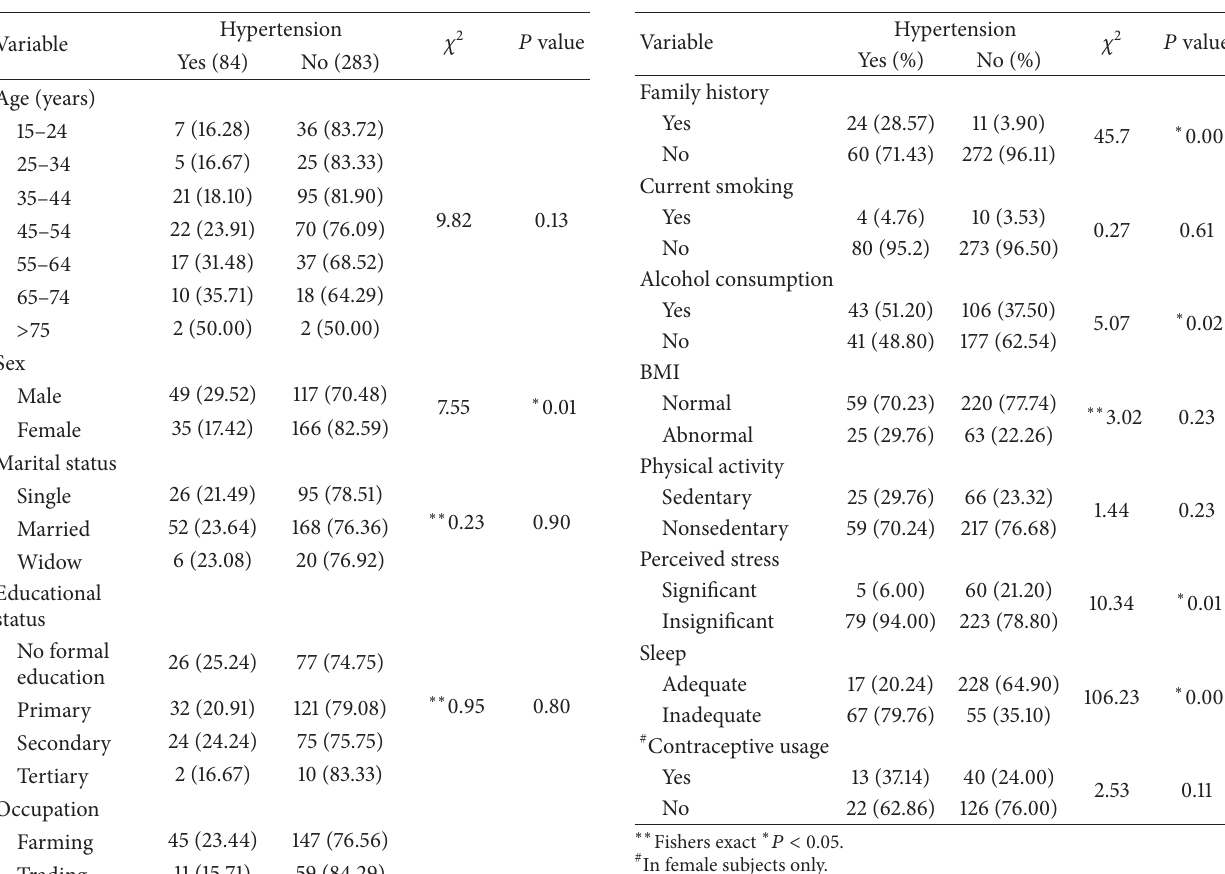
Table 3: Modifiable risk factors in hypertensive and nonhyperten- sive